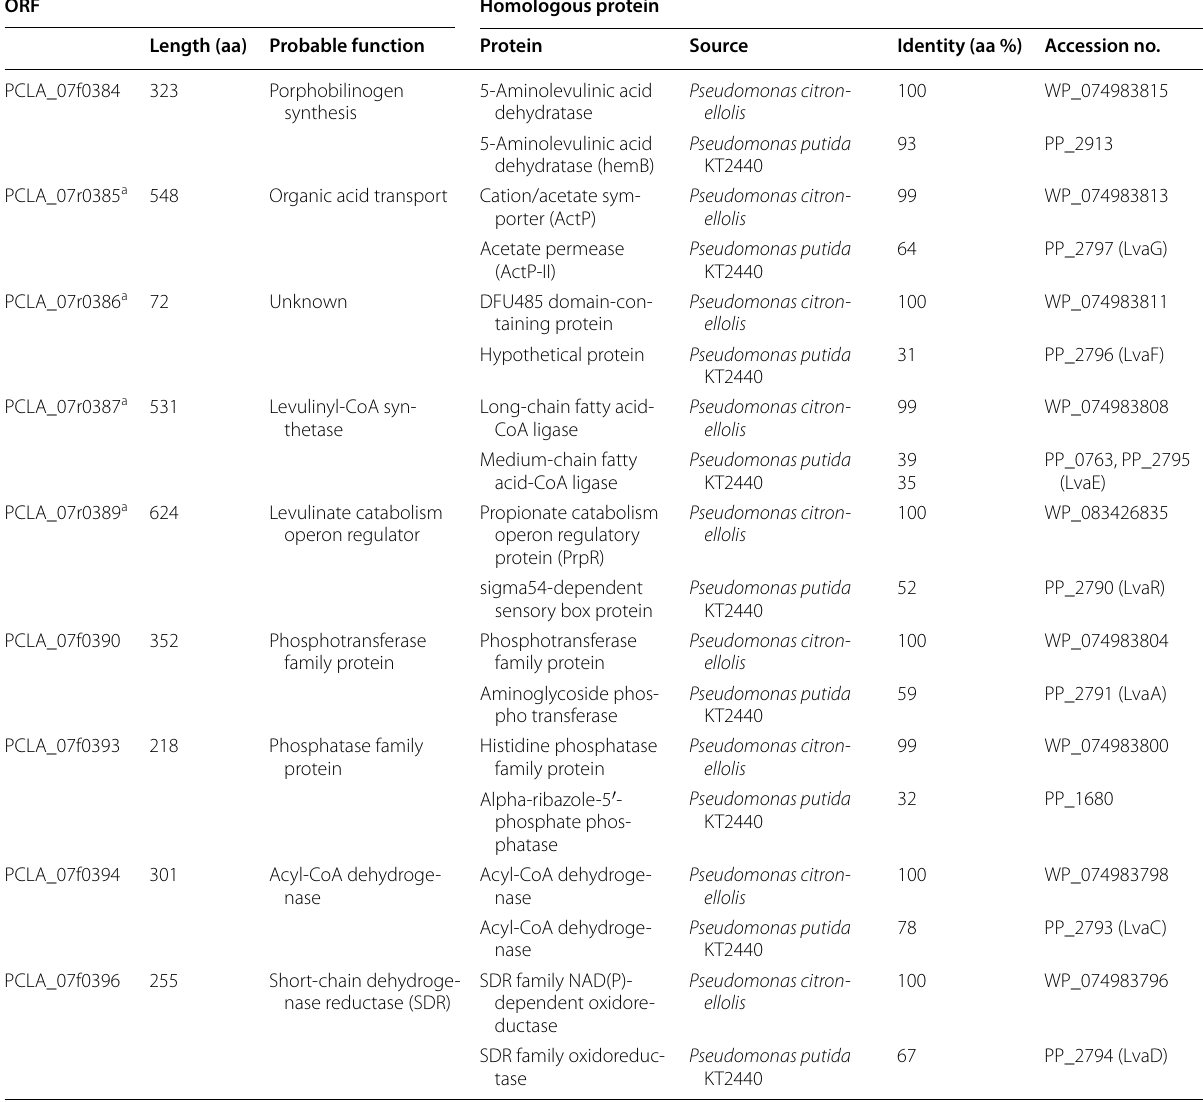
a ORFs are encoded in the complementary strand